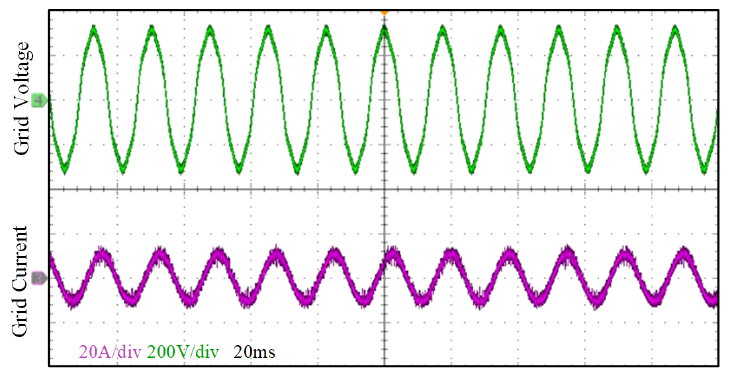
Figure 17. Grid-connected current waveform when the grid voltage is distorted.